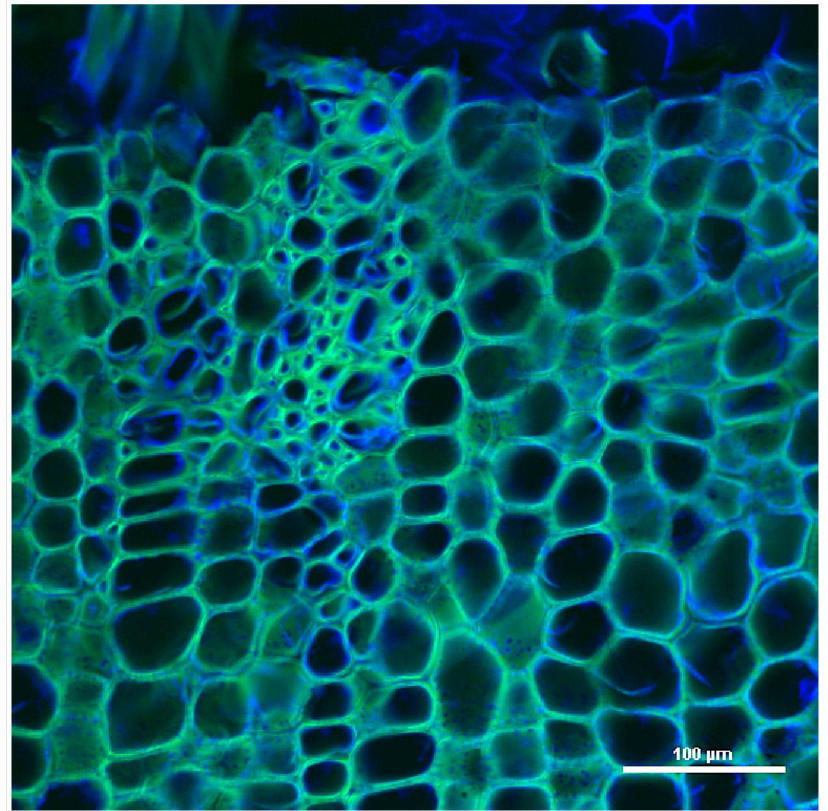
Figure 3. CLSM image from Cylindropuntia imbricata secondary xylem stained with safranin-fast green, excited at 405 nm (blue) and 488 nm (green) at the same time. Scale bar: 100 µ m. Image taken from personal